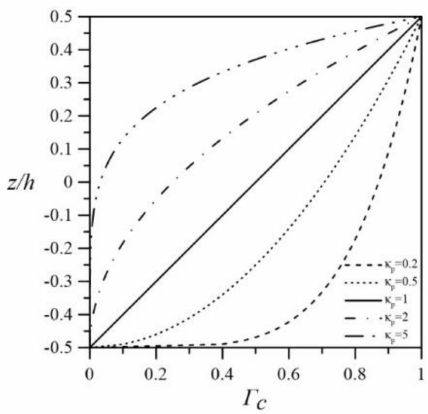
Figure 3. Through-thickness distributions of volume fractions of the ceramic material for a one- parameter power-law material model when κ p = 0.2, 0.5, 1, 2, and5. In the optimal design, a mass ratio R m is defined as